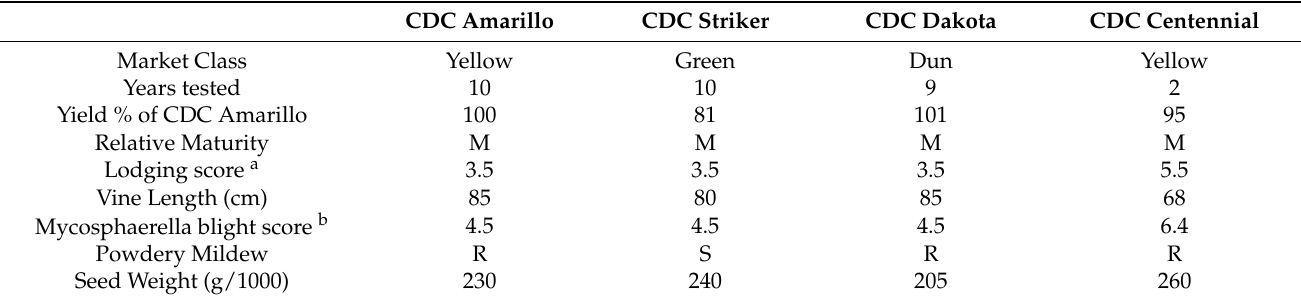
Table 1. Characteristics of field pea varieties tested in field studies. CDC Amarillo CDC Striker CDC Dakota CDC Centennial Market Class Yellow Green Dun Yellow